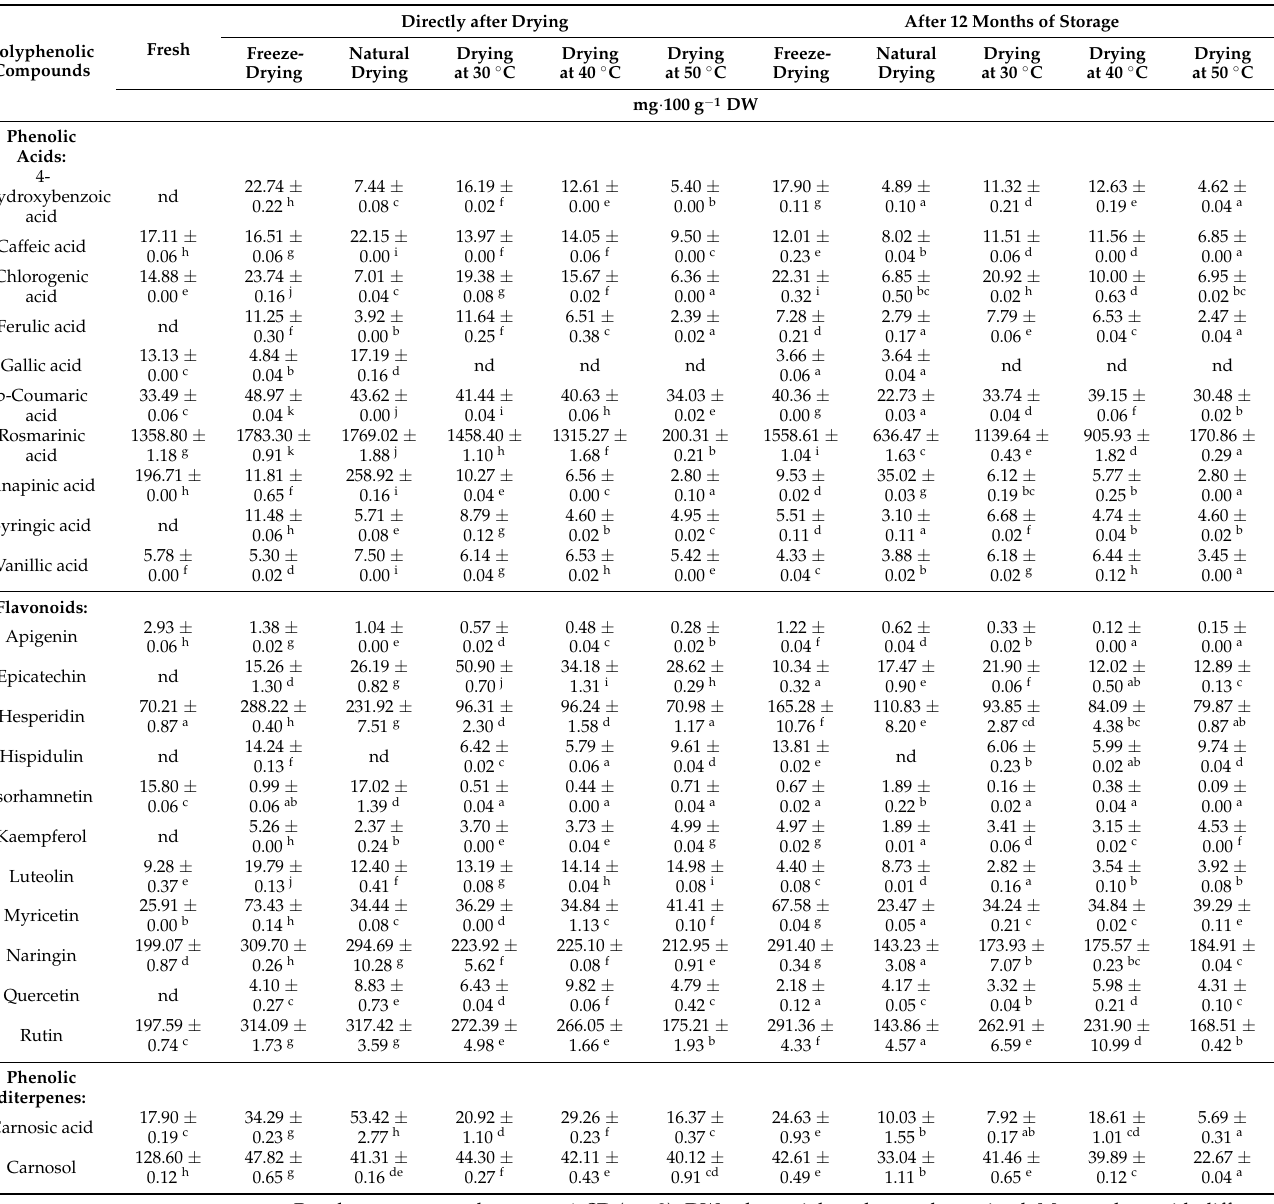
Table 5. Concentration of individual polyphenolic compounds in fresh, dried, and stored Salvia hispanica